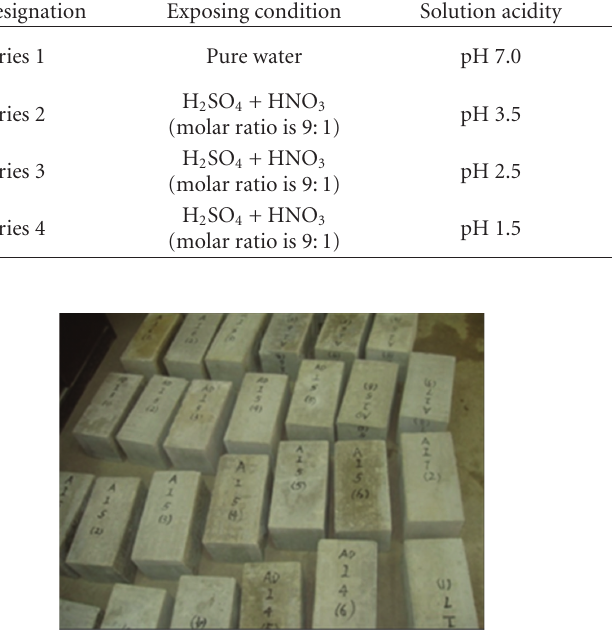
Figure 4: Concrete specimens exposed to the mixed acid